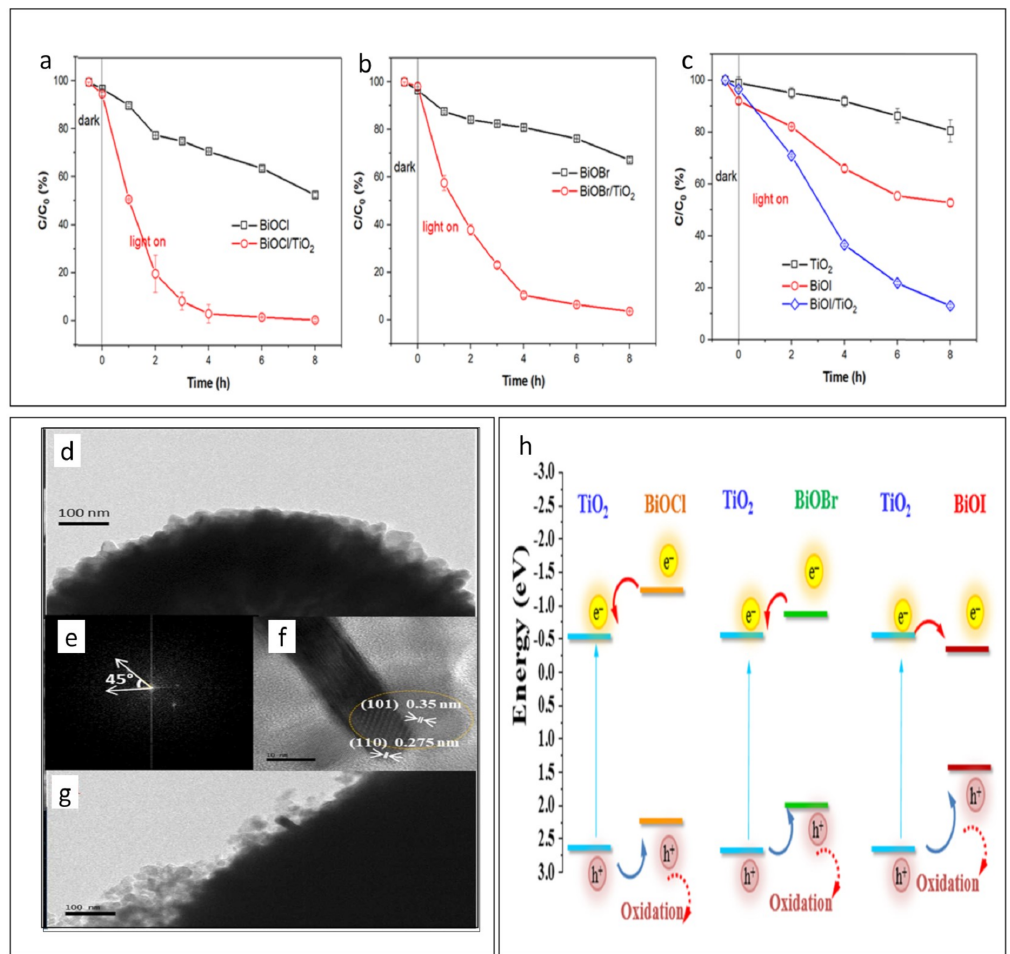
Figure 3. The kinetics of the photocatalytic degradation of PFOA by ( a ) BiOCl/TiO 2 , ( b ) BiOBr/TiO 2 , and ( c ) BiOl/TiO 2 ; ( d – g ) TEM images of BiOCl, ( h ) the band structures of BiOX/TiO 2 heterostructures (reprinted with permission, copyright Elsevier (2022))